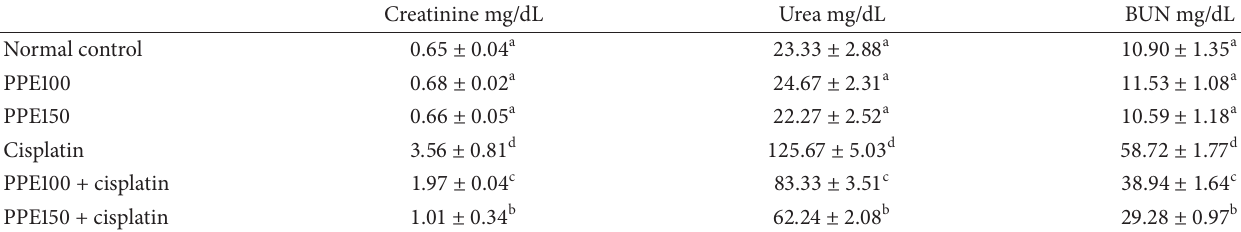
Table 3: Effect of Physalis peruviana L. extract on serum creatinine, urea, and BUN in normal and cisplatin induced ARI rats. Creatinine mg/dL